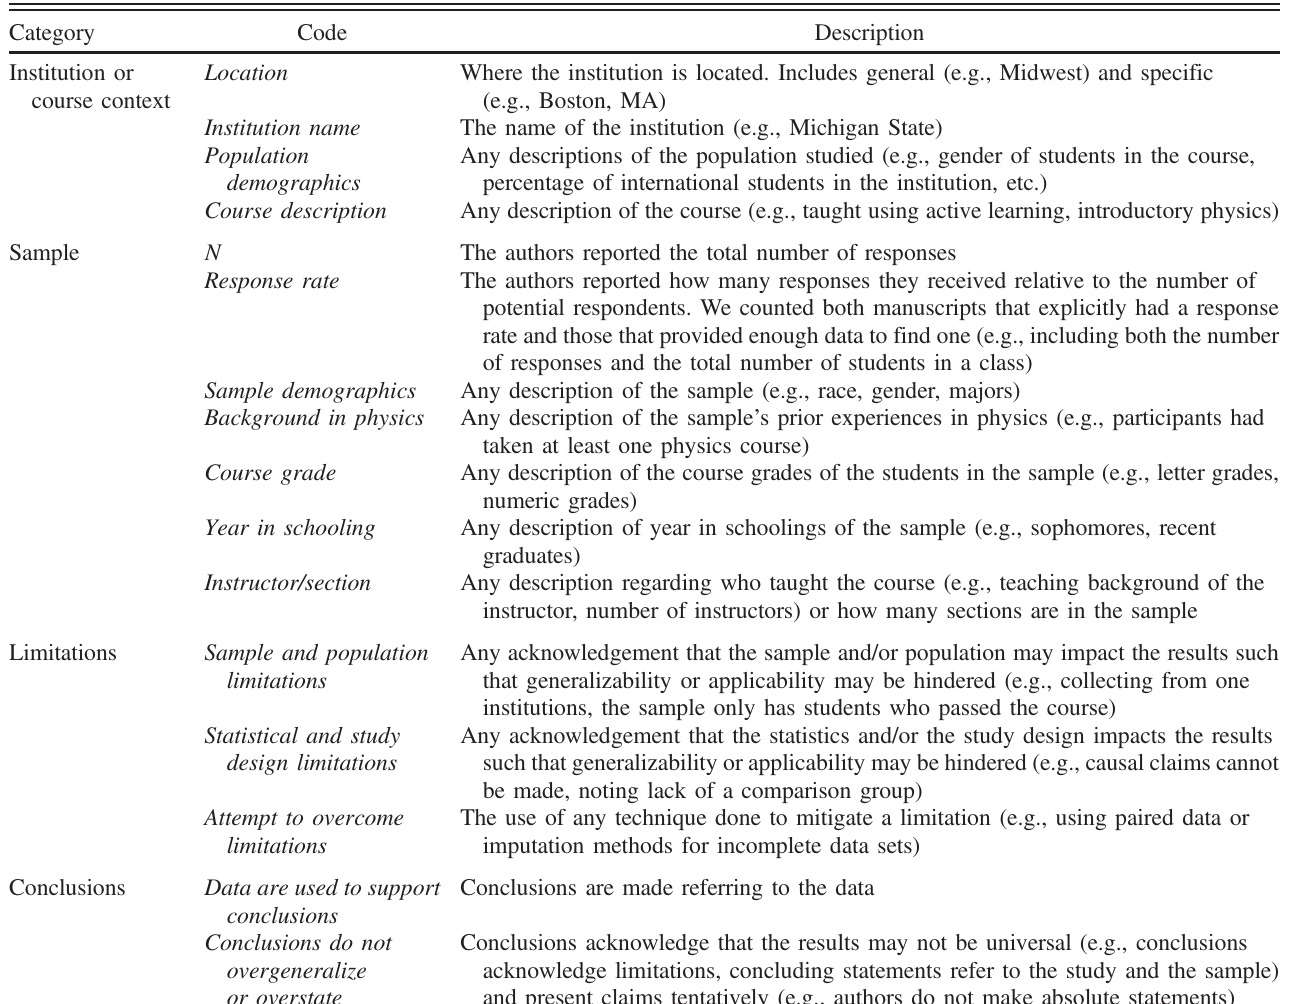
TABLE II. Coding scheme for phase